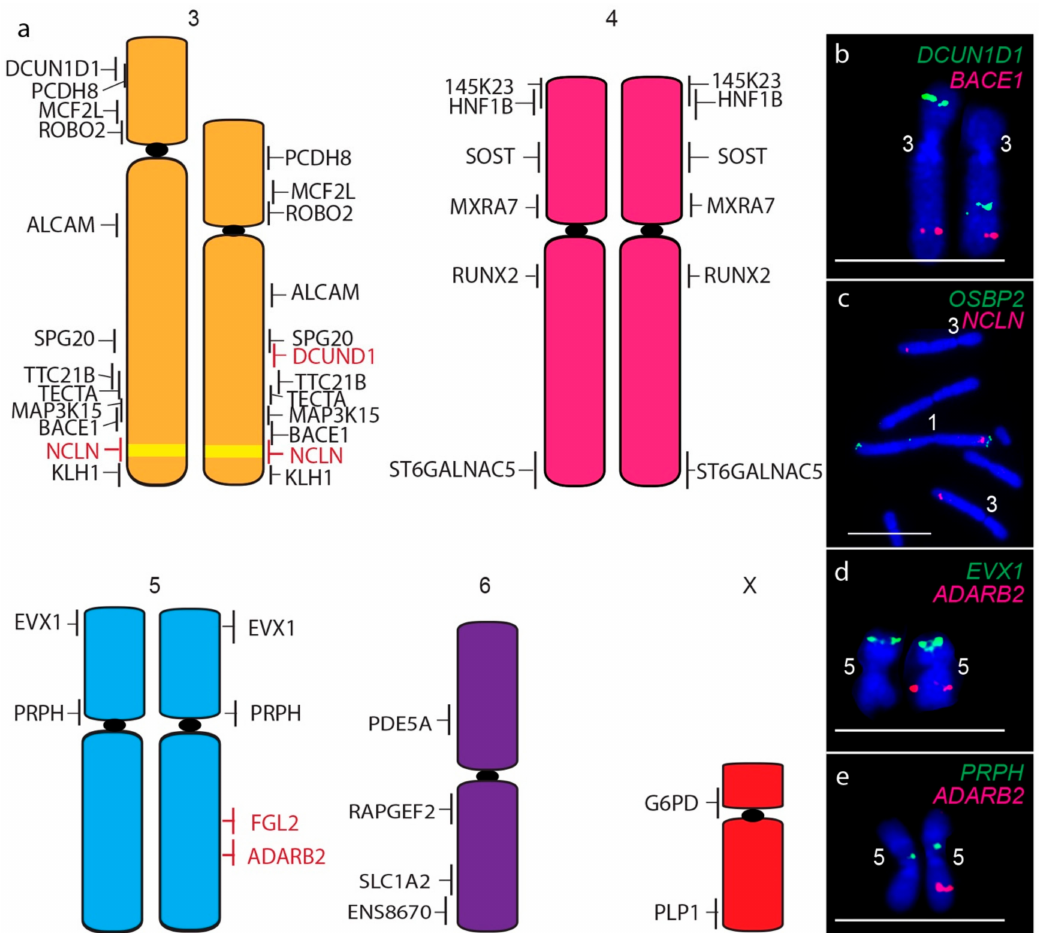
Figure 4. ( a ) Cytogenetic maps of Chromosomes 3 to X. Genes indicated in red di ff er in copy number between the two copies of chromosome 2. Flpter values ( ± 1 standard deviation) are indicated by vertical lines beside chromosomes. Chromosome 1 material on chromosome 3 is indicated in